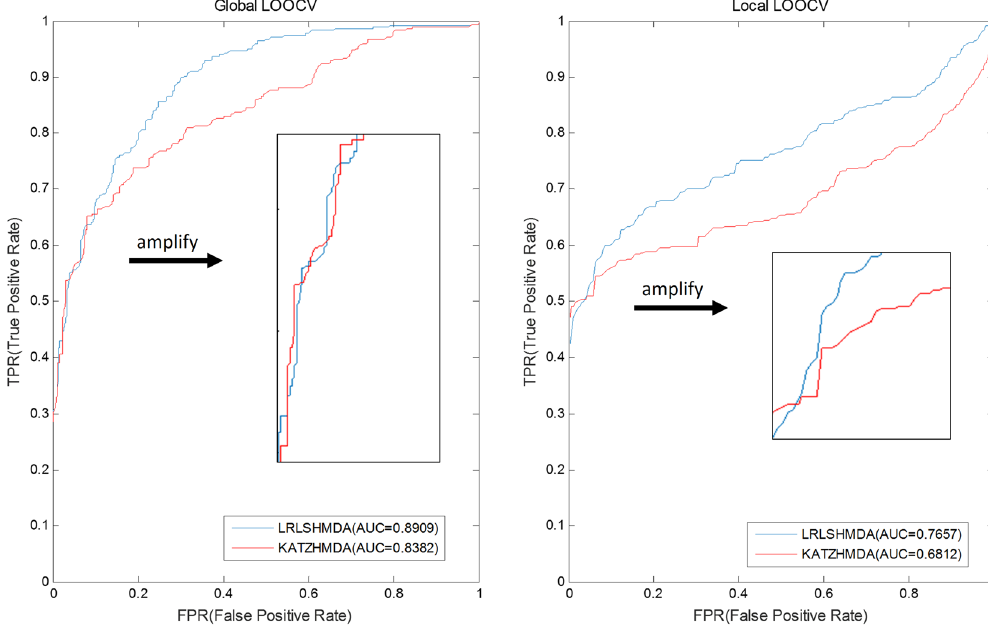
Figure 2. Prediction performance comparison between LRLSHMDA and KATZHMDA in the frameworks of both global and local